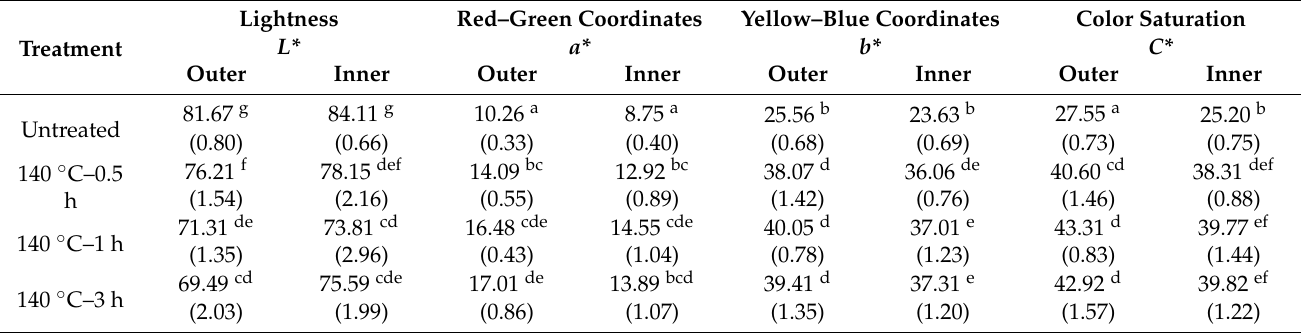
Table 2. The color of bamboo after tung oil treatment at different durations of